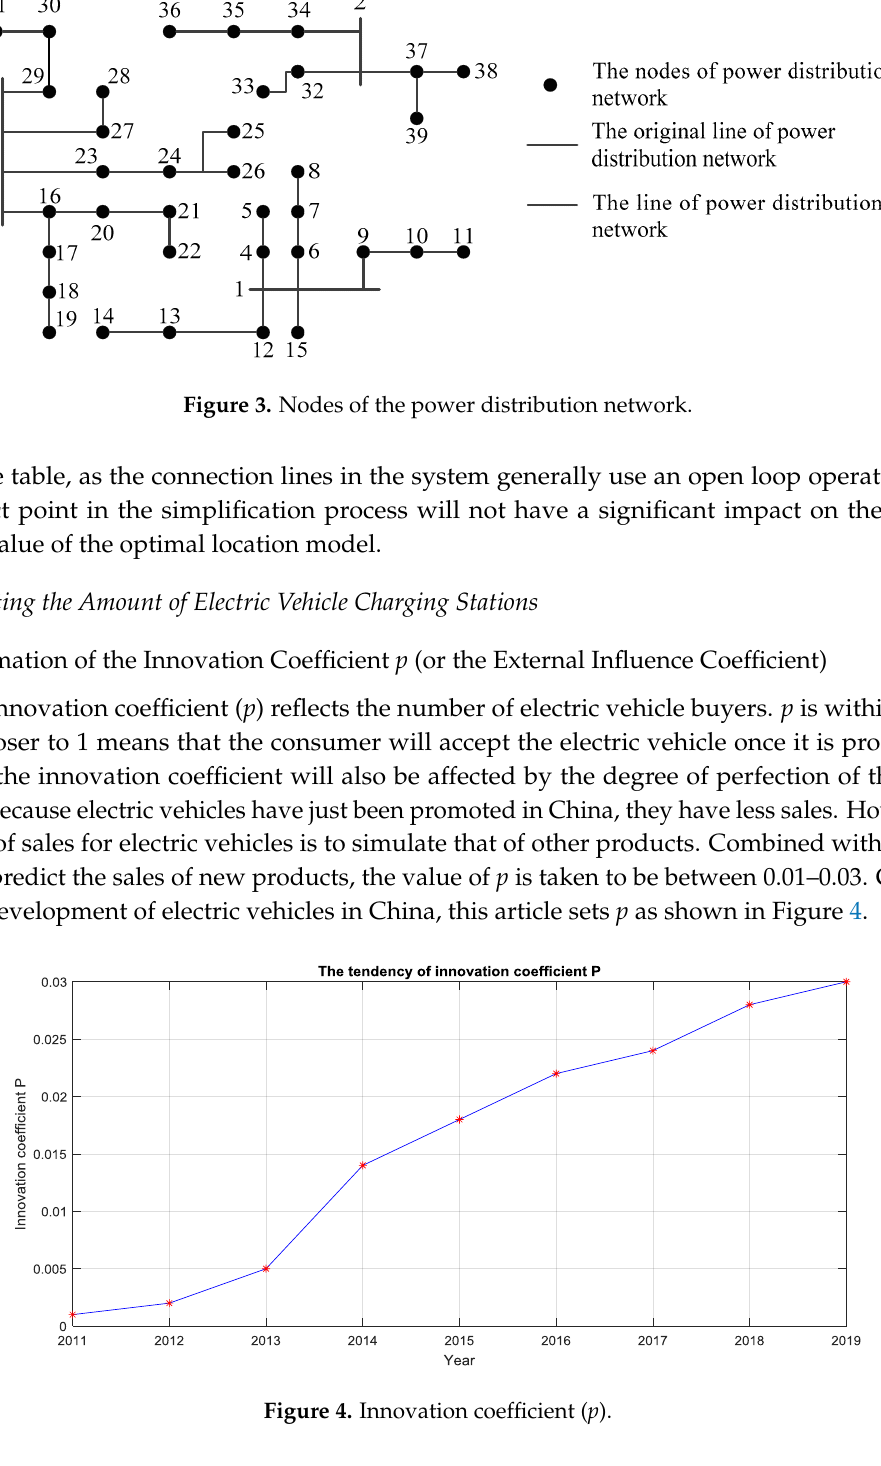
Figure 4. Innovation coefficient ( p ).